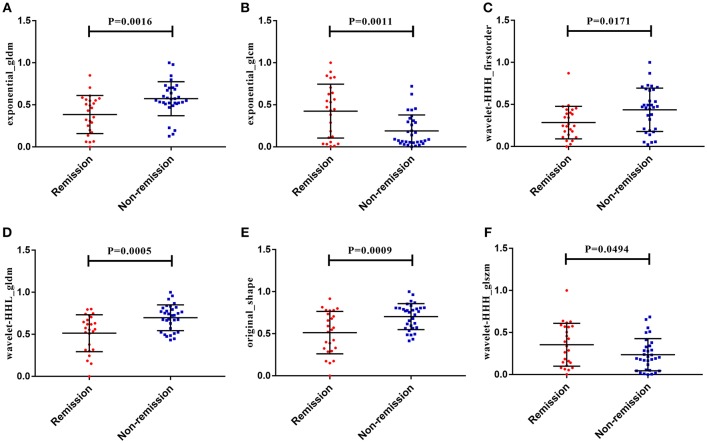
The six radiomics features showed significant differences between the different radiotherapeutic response (remission and non-remission) groups. (A) Exponential_gldm_DependenceVariance. (B) Exponential_glcm_SumEntropy. (C) Wavelet-HHH_firstorder_Kurtosis. (D) Wavelet-HHL_gldm_DependenceVariance. (E) Original_shape_Maximum3DDiameter. (F) Wavelet-HHH_glszm_SmallAreaLowGrayLevelEmphasis.